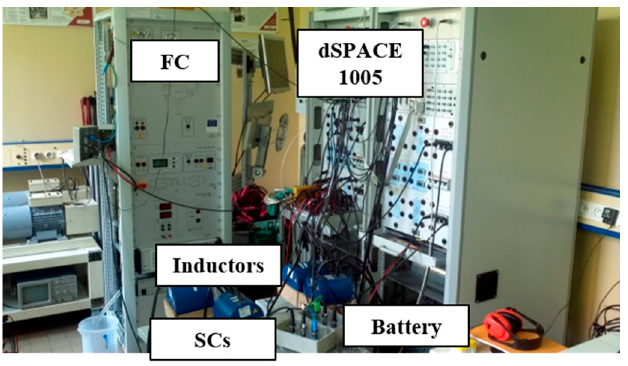
Figure 13. Experimental test rig.